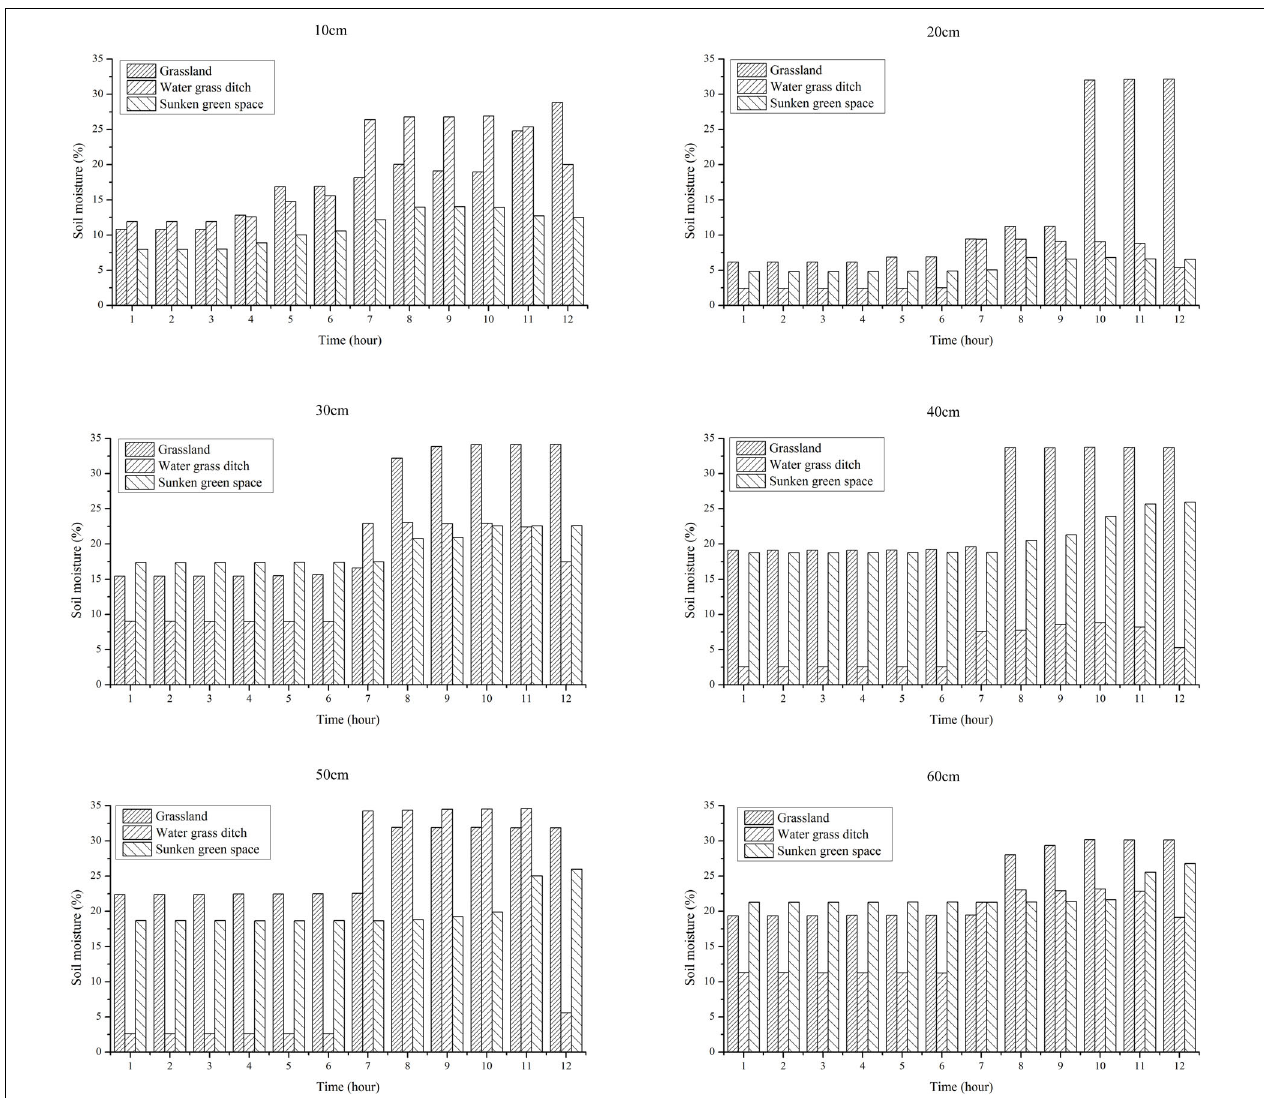
FIGURE 11 | Soil moisture at different soil depths under different sponge measures during the rain